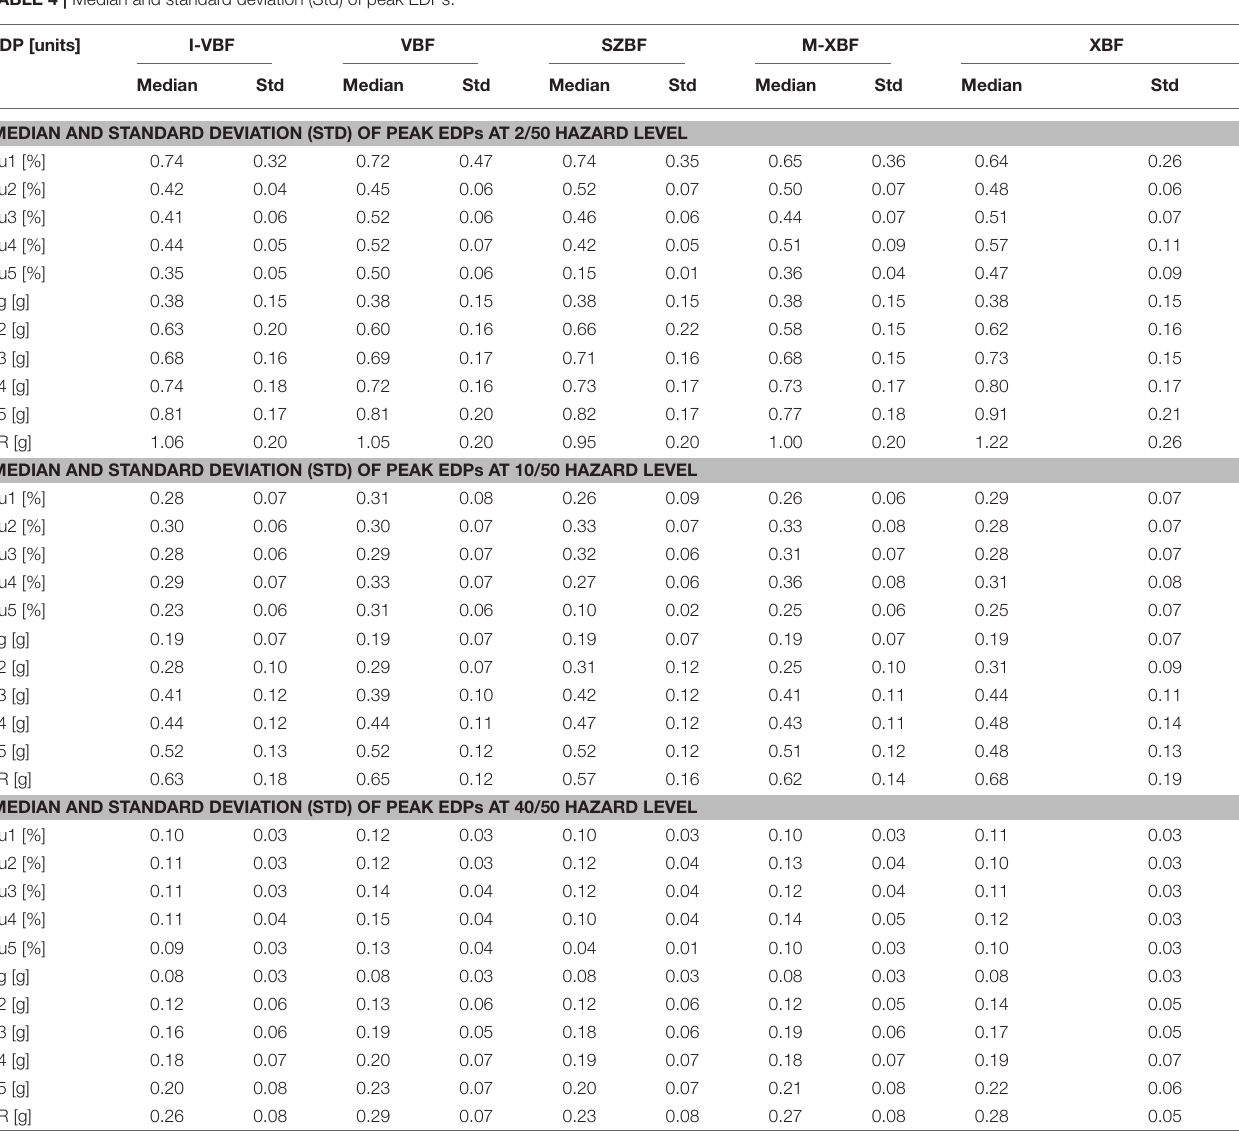
TABLE 4 | Median and standard deviation (Std) of peak